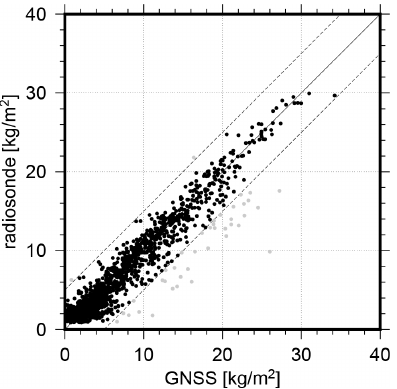
Figure 11. Comparison of IWV derived from GNSS and radioson- des; differences > 5kgm − 2 are shown in gray (2.6% of in total 1495 differences).